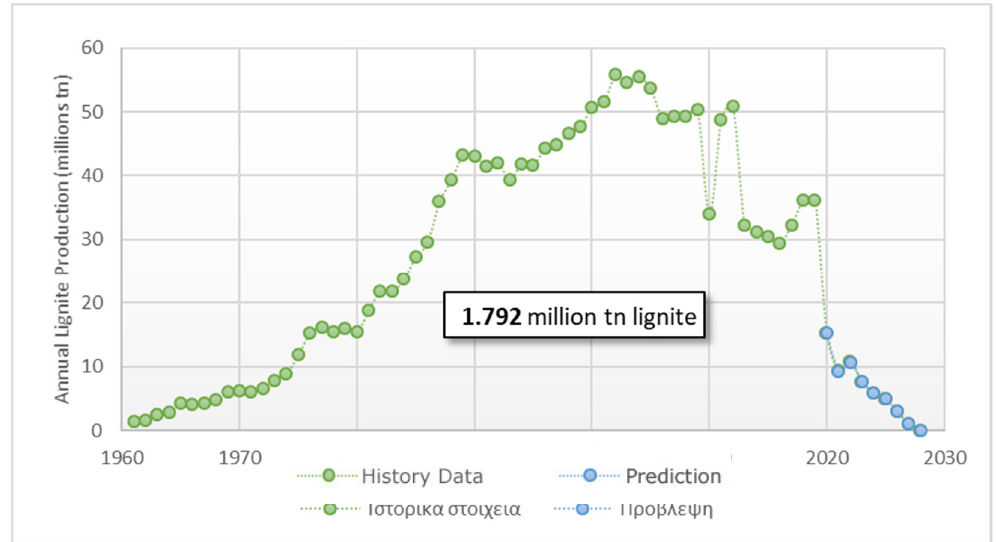
Figure 2. Lignite production in the Mines of Public Power Corporation (PPC) SA in the region of Western Macedonia. Adapted from [11].